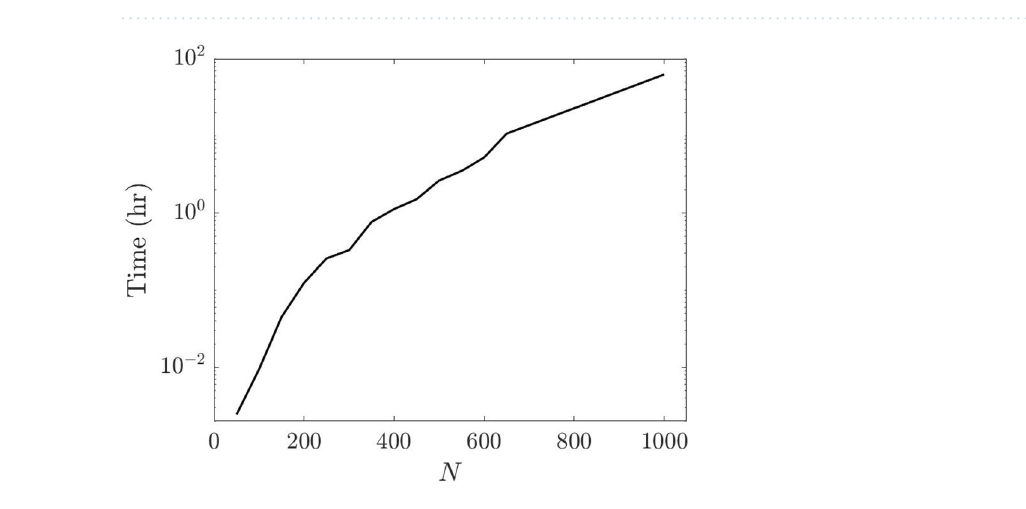
Figure 7. Time (h) versus network size (N). As the number of nodes increases, the calculation time increases